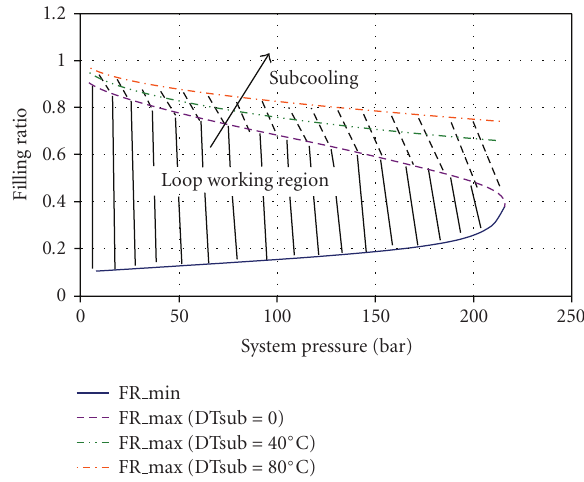
Figure 8: Filling ratio boundaries as a function of pressure and downcomer subcooling for IRIS EHRS